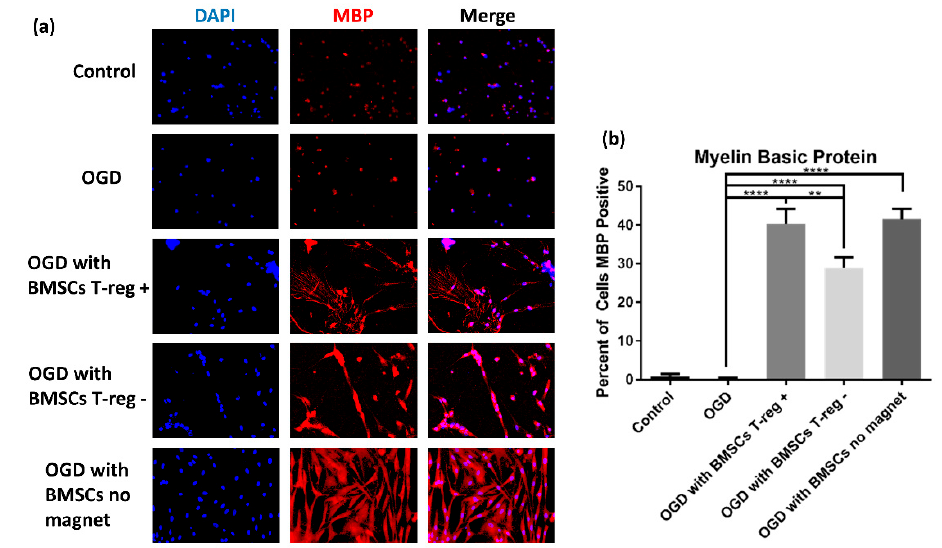
Figure 4. BMSCs with T regs confer increased myelination compared to BMSCs without T regs . ( a ) Fluorescently labeled cell nuclei with DAPI, OPC myelin processes labeled with myelin basic protein (MBP), and merge. ( b ) Quantification of MBP+ cell count in each group shown as percent of cells expressing MBP per image, mean ± SEM.